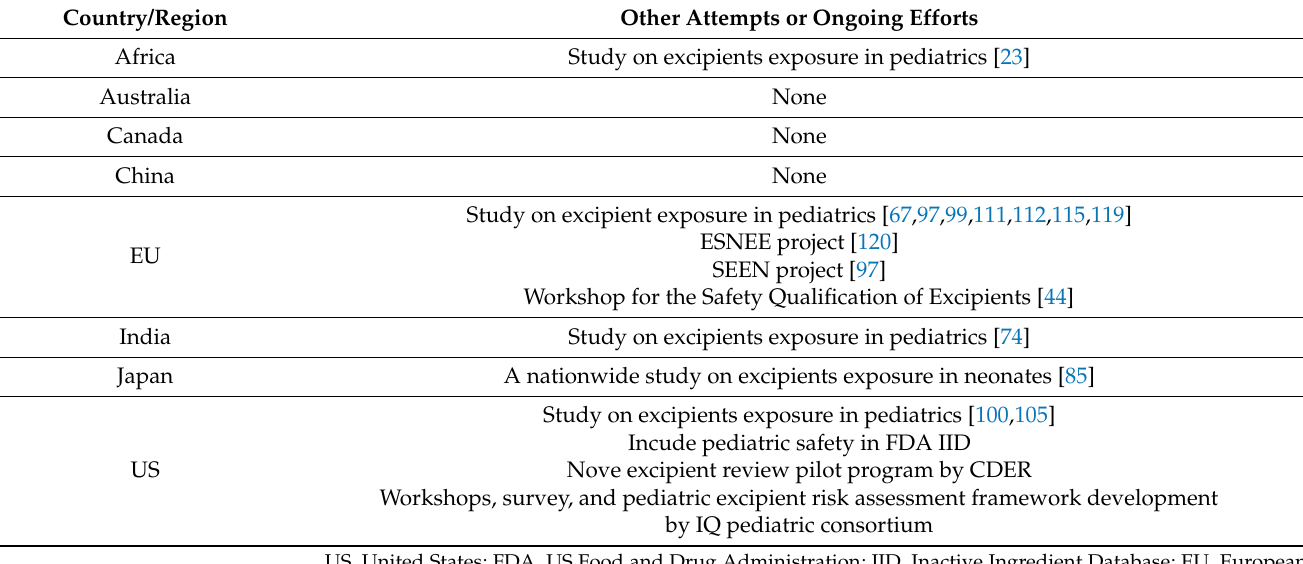
Table 2. Summary of attempts or ongoing efforts in each country and